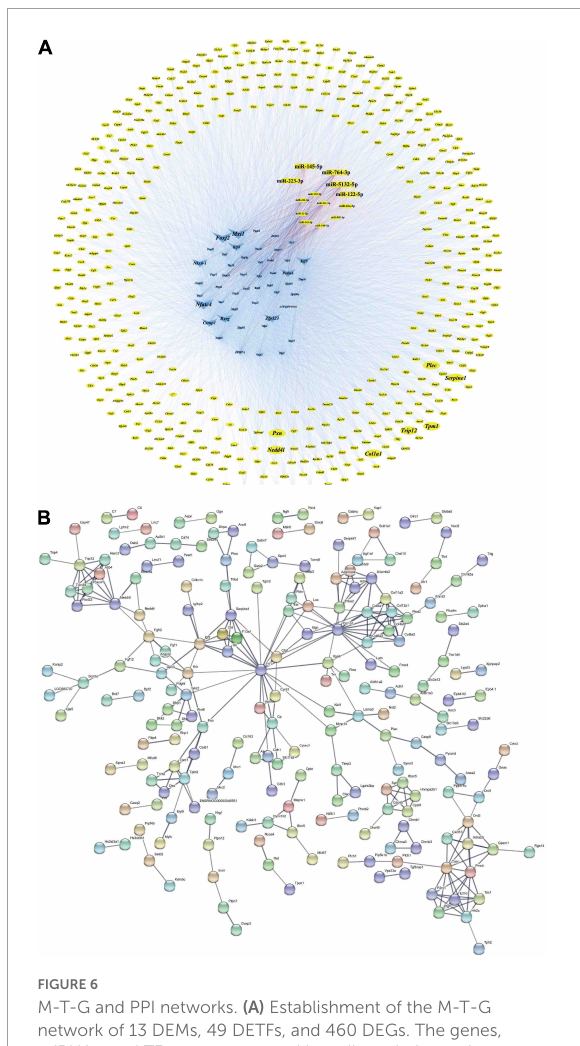
cytohubba plug-in, including Serpine1 , Pxn , Nedd4l , Col1a1 , Plec , Trip12 , and Tpm1 ( Table 3 ).